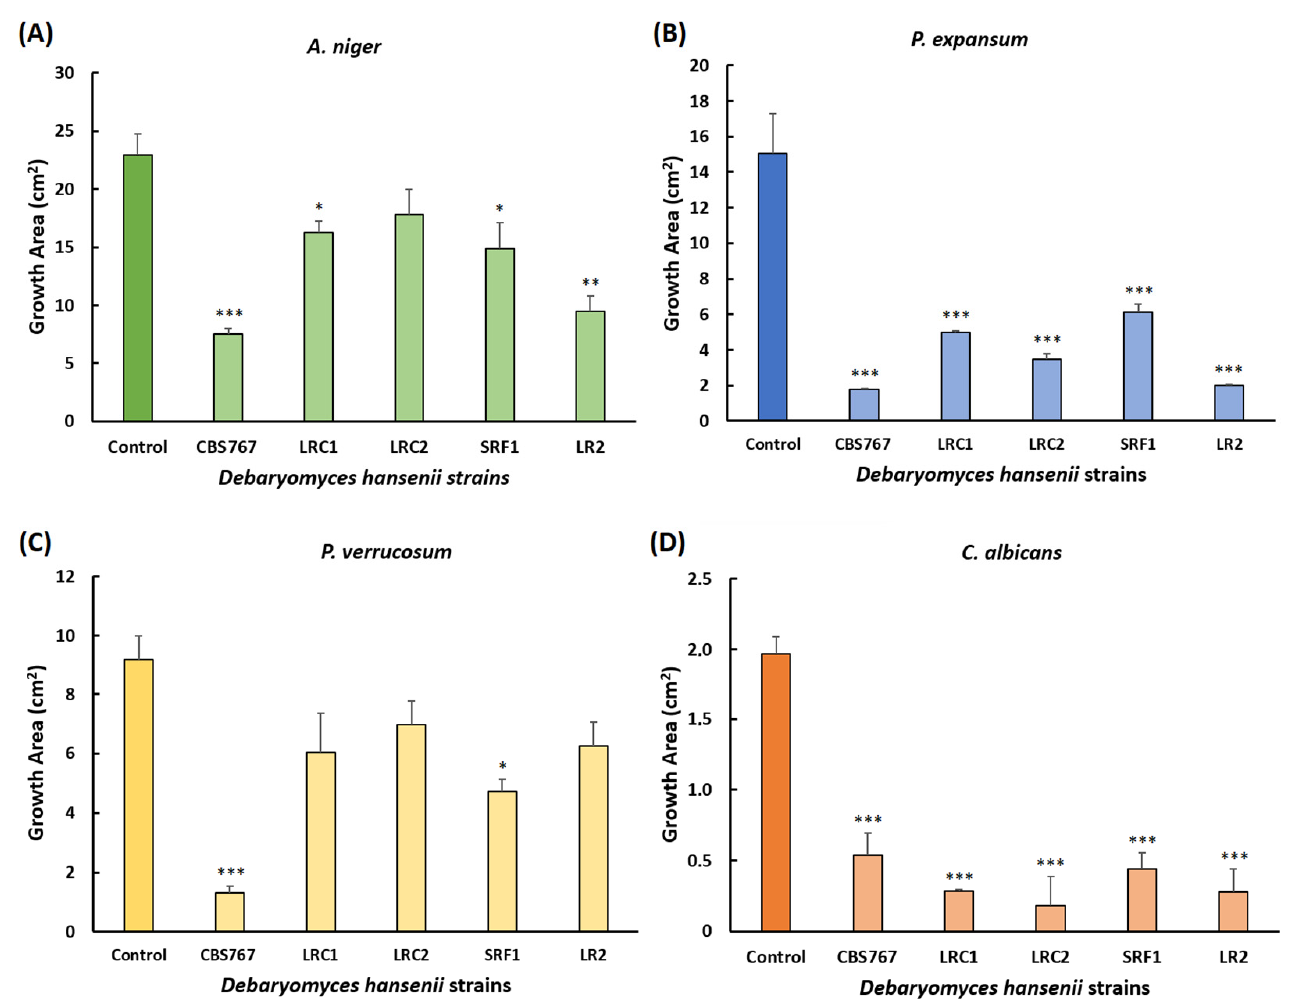
Figure 2. Radial inhibition of potentially pathogenic fungi by selected strains of D. hansenii. ( A – D ) Growth area (cm 2 ) of the different fungi A. niger ( A ), P. expansum ( B ), P. verrucosum ( C ), and C. albicans ( D ). Mean values ± standard deviation obtained in three independent biological replicates are plotted. Statistical significance shown in the figure (* p < 0.05, ** p < 0.01, *** p < 0.001) represents the significant influence of the different D. hansenii strains on the mycelial growth of the different fungus with respect to the control plates. More detailed statistical analysis can be found in the supplementary data (Table